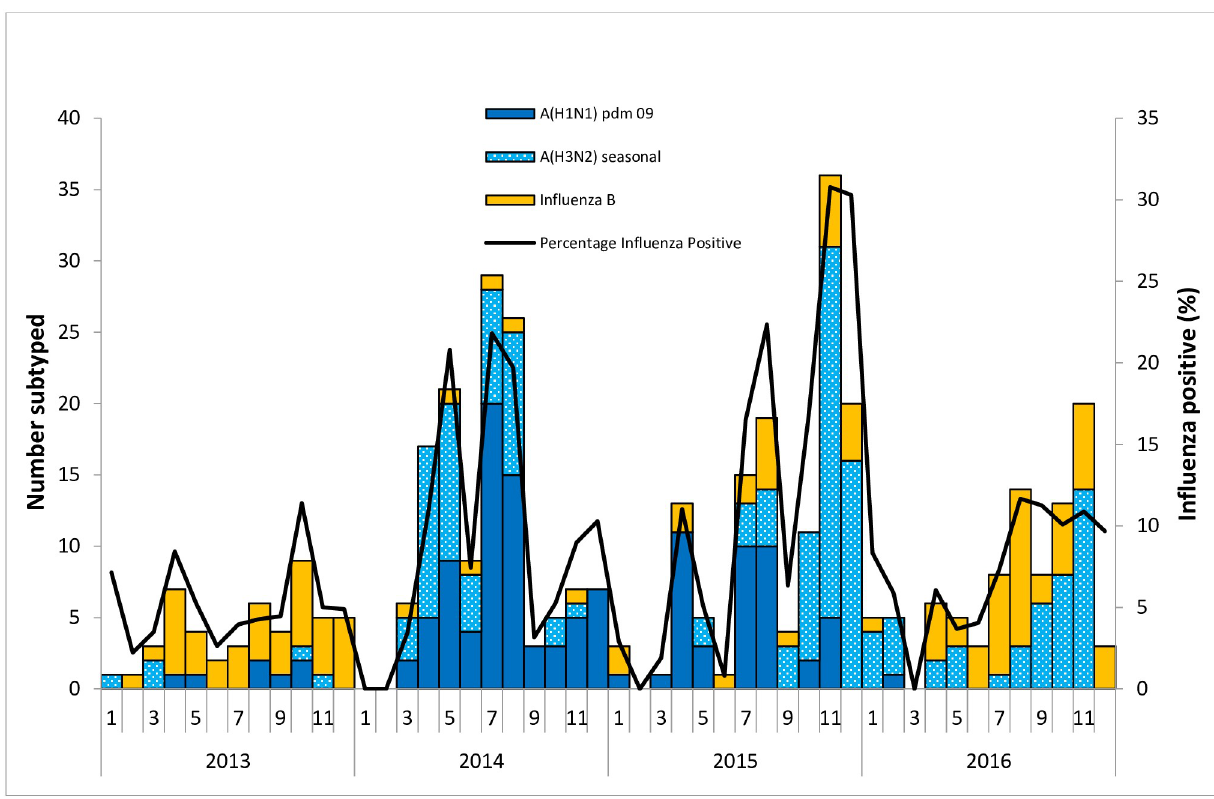
Fig 3. Influenza activity and circulating subtypes in Uganda, 2013–2016.